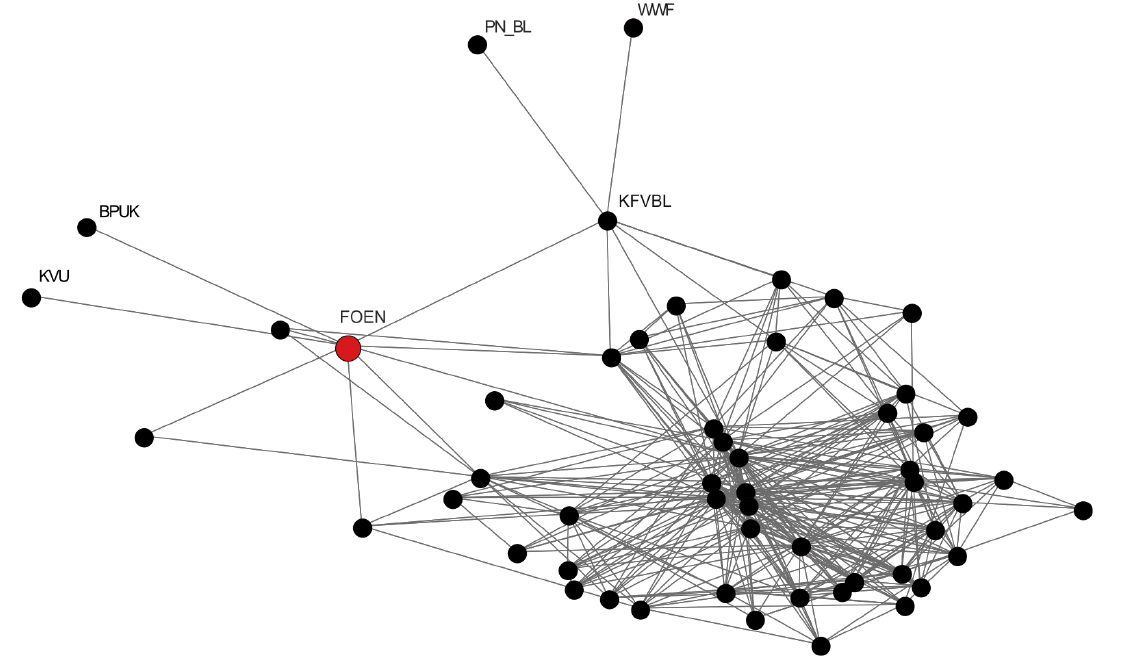
Fig. 4 . Ego network (order two) of collaboration ties of the Swiss Federal Office for the Environment (FOEN, indicated by red circle) in the water supply governance network of a peri-urban region in the Swiss canton of Basel-Landschaft. The figure illustrates the periphery connector role of the FOEN. KVU and BPUK are the conferences of heads of Swiss state agencies for environmental protection and spatial protection, respectively. The node labeled KFVBL represents the state level fishery association, itself a periphery connector. It integrates two nature protection organizations (PN_BL and WWF) into the